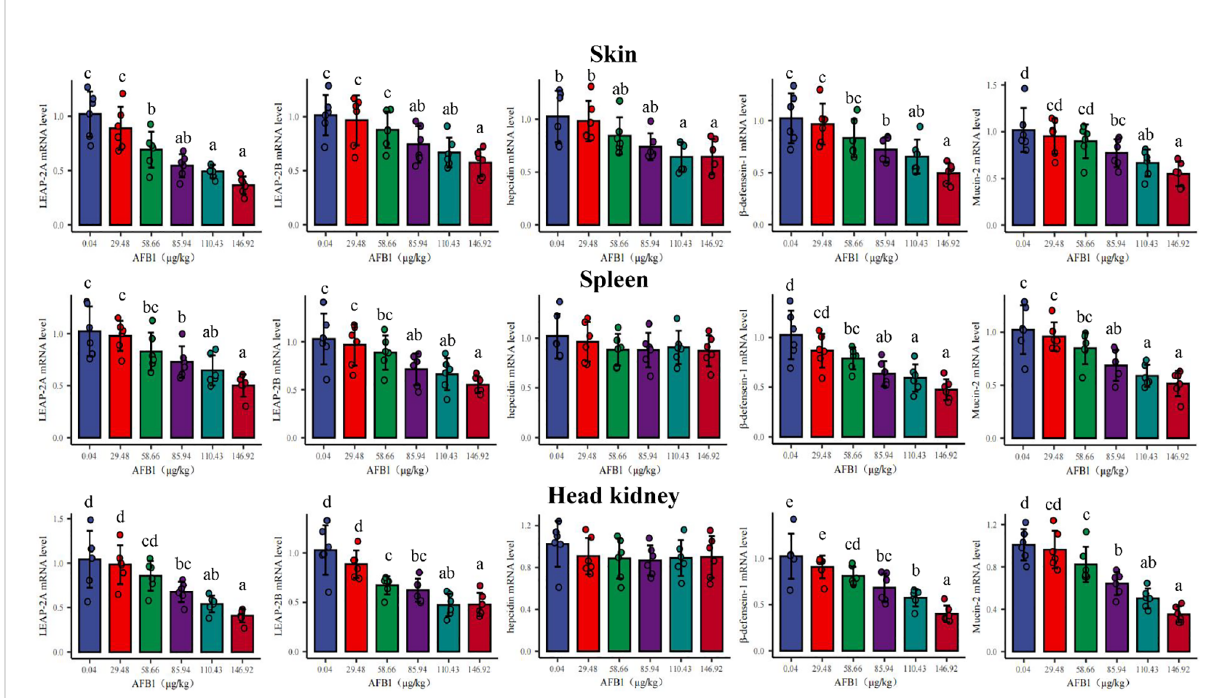
FIGURE 3 Effects of dietary AFB1 ( m g/kg) on the mRNA levels of antibacterial peptides ( LAEP-2A , LEAP-2B , hepcidin , b -defenscin-1 ) and Mucin-2 of skin, spleen, and head kidney of grass carp after challenged with A. hydrophila . n=6 (six fi sh in each group). Different letters represent a signi fi cance difference (P <